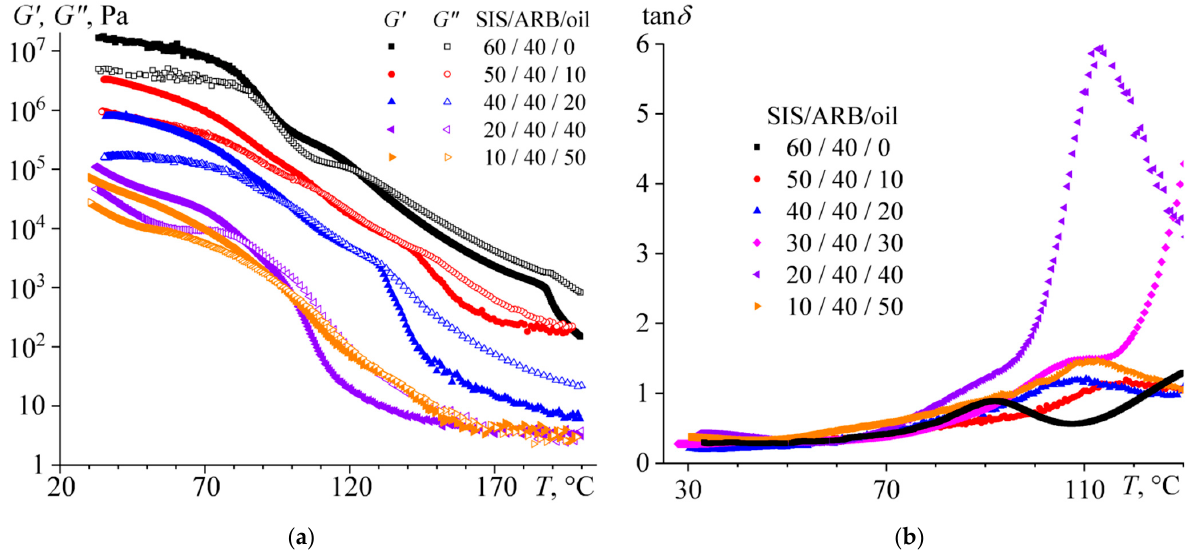
Figure 7. Temperature dependences of ( a ) storage and loss moduli and ( b ) loss tangent for triple mixtures containing the same concentration of asphaltene/resin blend (ARB) and different ratio between styrene-isoprene-styrene triblock copolymer (SIS) and naphthenic oil.